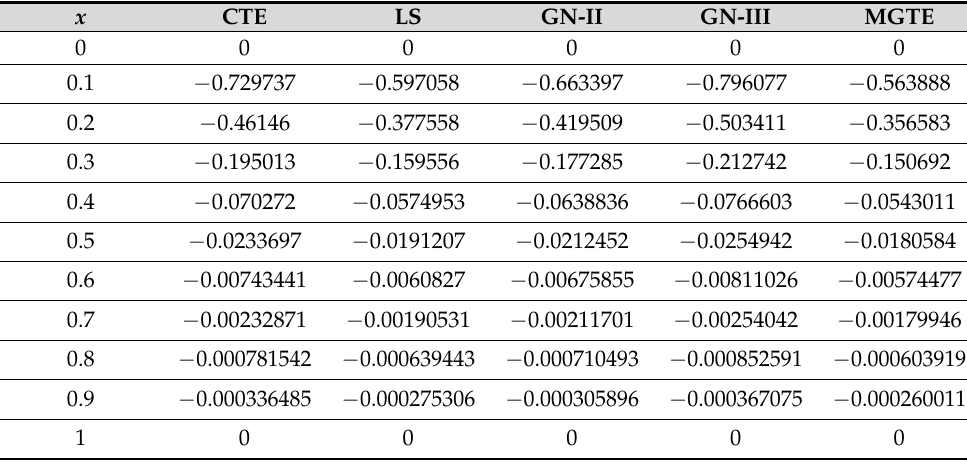
Table 4. The values of displacement u for various thermoelastic